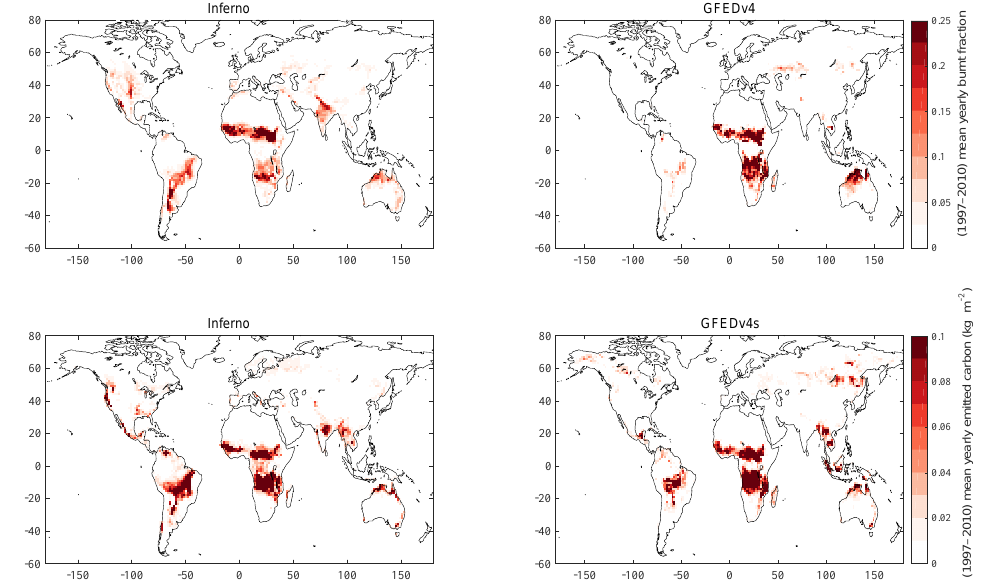
Figure 2. 1997–2010 mean yearly burnt fraction (above) and emitted carbon (below, in kgm − 2 ) . Shown for INFERNO on the left (with CRU-NCEP meteorology and interactive ignitions; ignition mode 3) and for GFED on the